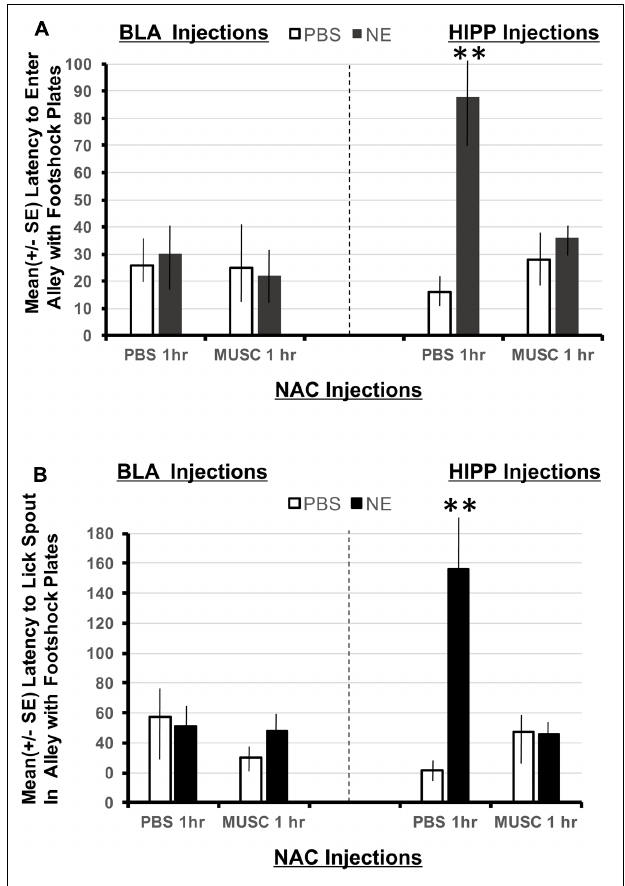
FIGURE 5 | (A) Mean (+SE) latency to enter the Y-maze alley resembling the footshock context in animals with accumbens shell cannulae implants and implants in either the basolateral amygdala or ventral hippocampus. Only animals given norepinephrine (NE) in the hippocampus took significantly longer to enter the arm of the Y-maze that resembled the footshock context ( p < 0.01). Although the shock and injection was given 48 h previously, these animals maintain high contextual memory for the shock compartment. This effect is blocked in animals given muscimol in the accumbens. ∗∗ denotes p < 0.01. (B) Mean (+SE) latency to lick from the water spout located in the Y-maze ally resembling the footshock context in animals with accumbens shell cannulae implants and implants in either the basolateral amygdala or ventral hippocampus. Animals in the BLA-NE/PBS not only readily entered the similar shock context, but they also readily drank from the spout located at the end of the arm. However, the same dose of norepinephrine in the hippocampus produced significantly longer latencies to lick from the spout compared to all other treatment groups ( p <